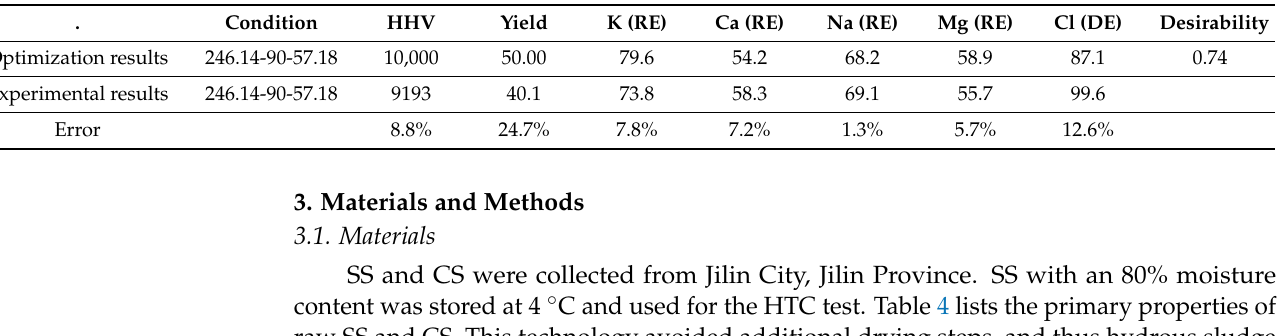
Table 3. Optimization and experimental results and error analysis.